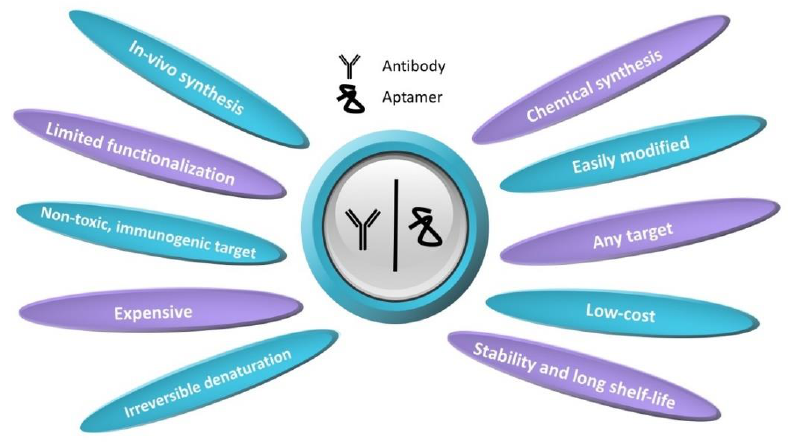
Figure 2. Main advantages of aptamers compared to antibodies.